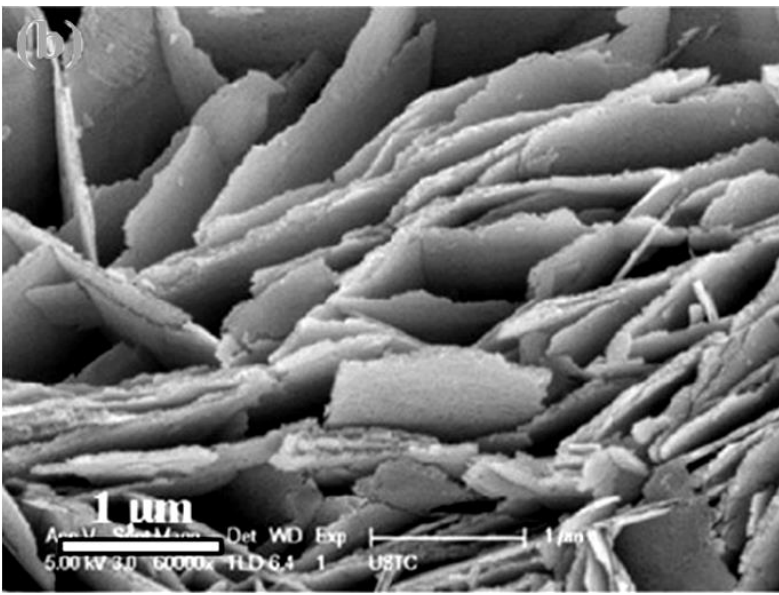
Figure 1. Field-emission-scanning electron microscopy (FE-SEM) image of the ZnO nanosheets. Reprinted with permission from [39]. Copyright 2012: Elsevier.